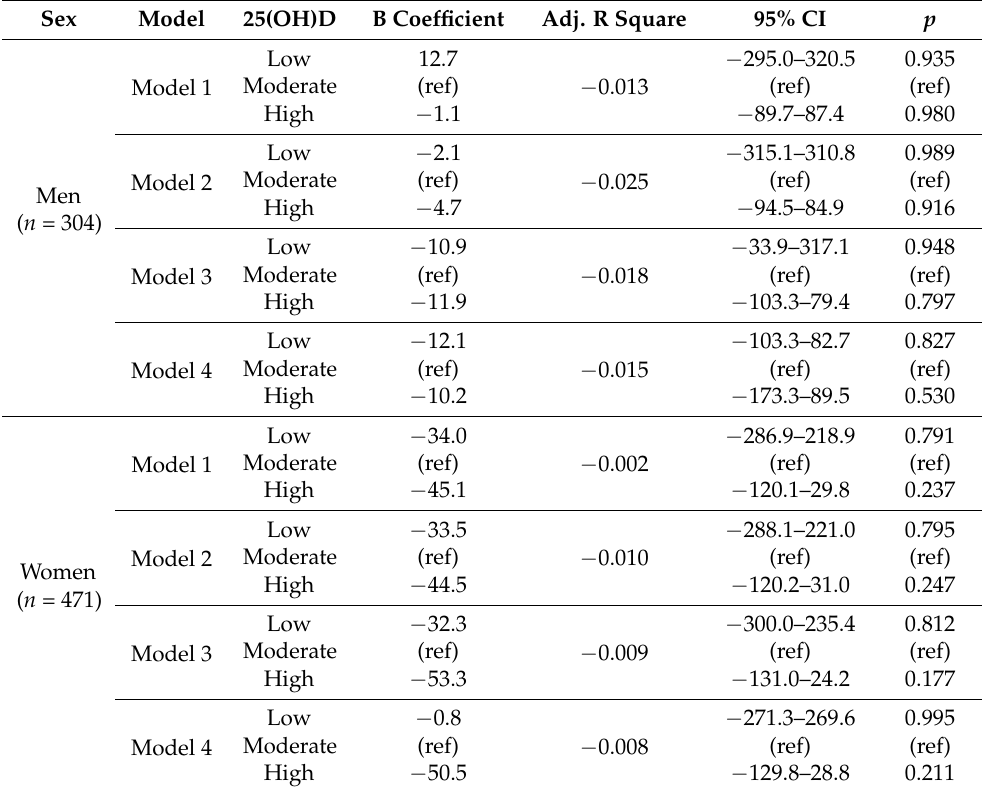
Table 7. Association between different 25(OH)D cut-offs and Telomere length by sex at 36